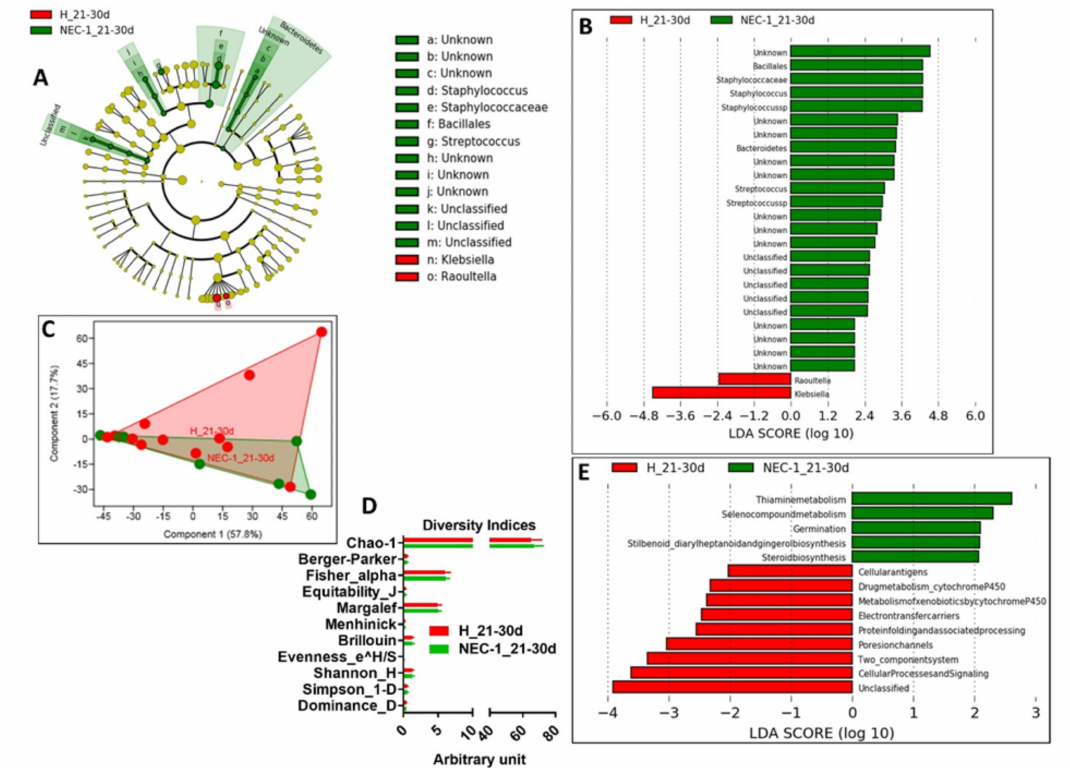
Figure 3. A specific gut microbiota and microbiome exist in the third 10-days of life in healthy vs. NEC-1 children. ( A ) Comparative analysis of the gut microbiota by LDA e ff ect size (LEfSe): the cladogram shows bacterial taxa significantly higher in the group of children of the same color, in the fecal microbiota between healthy (H) vs. NEC-1 children, in the third 10-days of life, 21 to 30 days ( D ) (the cladogram shows the taxonomic levels represented by rings with phyla at the innermost and genera at the outermost ring and each circle is a bacterial member within that level); ( B ) LDA score used to build the cladogram in (A); ( C ) PCA of the gut microbiota; ( D ) indices of gut microbiota diversity; ( E ) LDA score for microbial pathways. N = 13 for H and N = 7 for